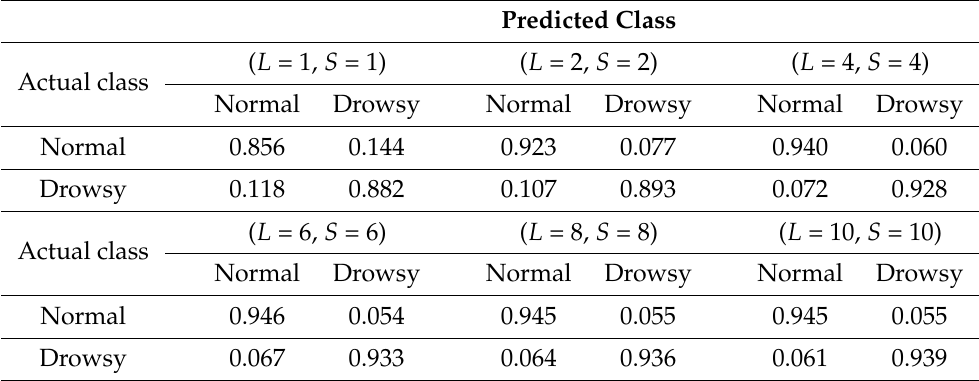
Table 7. Normalized confusion matrix of the proposed network with a symmetric parameter.